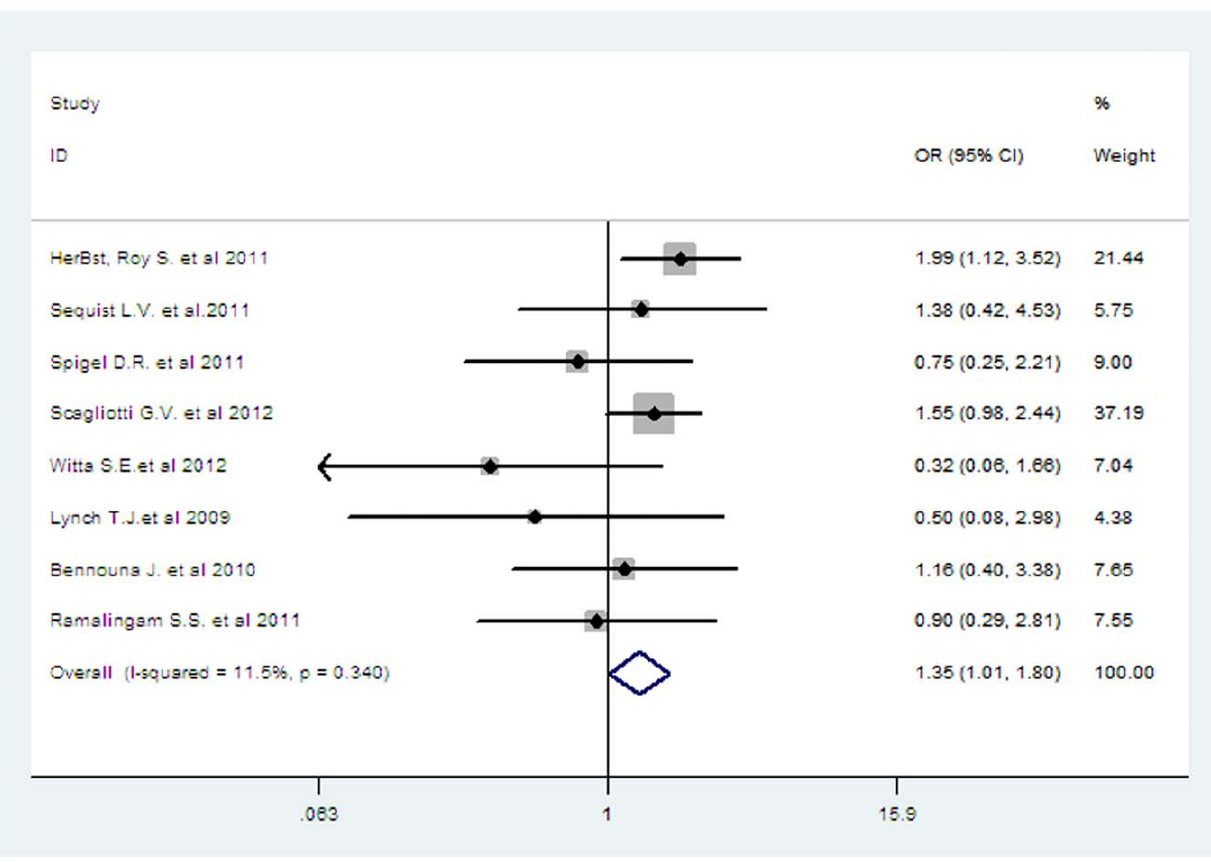
Figure 4. Comparison of ORR between combining targeted therapy and erlotinib alone.